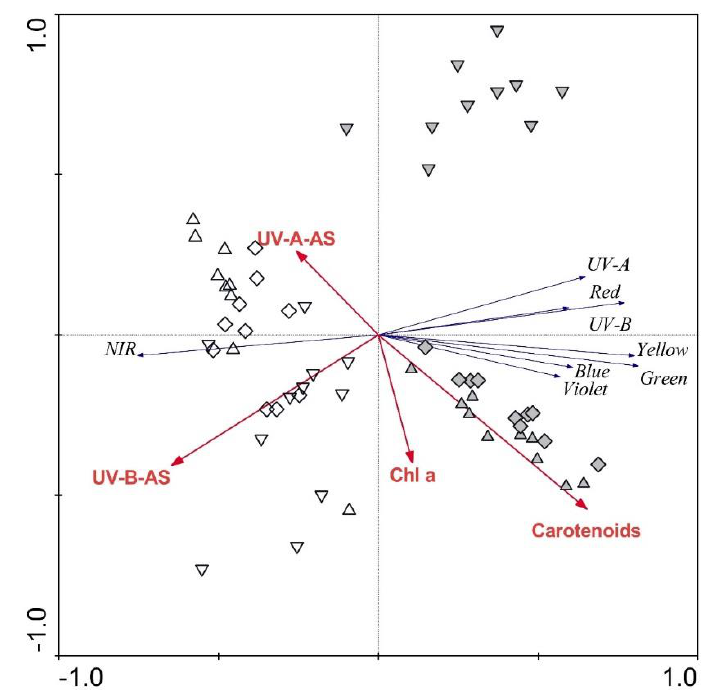
Figure 5. Redundancy analysis plot showing the strength of the associations between the frond traits and the regions of the reflectance spectra for Phyllitis scolopendrium . Up-triangles, specimens from the upper habitat; diamonds, specimens from the middle habitat; down-triangles, specimens from the lower habitat; white symbols, April samples; grey symbols, June samples; Chl a, chlorophyll a ; AS, absorbing substances; NIR, near-infrared.